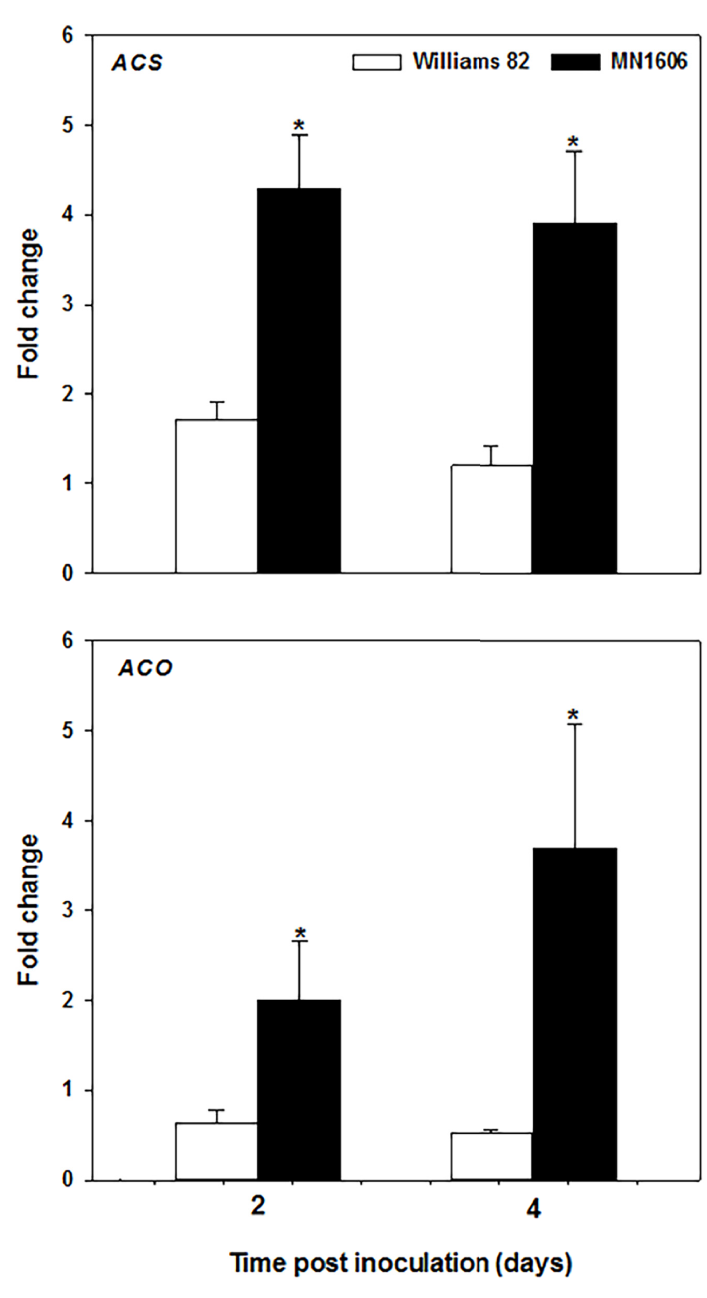
Fig 1. Induction of ethylene biosynthesis genes in response to Fusarium virguliforme infection. Expression analysis of 1-aminocyclopropane-1-carboxylic acid synthase ( ACS ), and 1-aminocyclopropane-1-carboxylic acid oxidase ( ACO ) genes in response to Fusarium virguliforme infection in soybean roots at 2 and 4 days post inoculation (DPI). Soybean seeds of MN1606 (resistant) and Williams 82 (moderately susceptible) were planted in Fv infested soil and roots were collected at 2 and 4 DPI for quantification of ACS and ACO gene expression using real time PCR. The soybean actin gene was used as an internal control. The level of expression is shown relative to that of time zero plants (non-inoculated). Each column represents the mean fold change of six biological samples (3 replicates × 2 runs), and each sample consisted of a pool of two plants. Error bar indicates standard error of the mean (n = 6). � indicates a significant difference ( P < 0.05) between the two cultivars within the same time